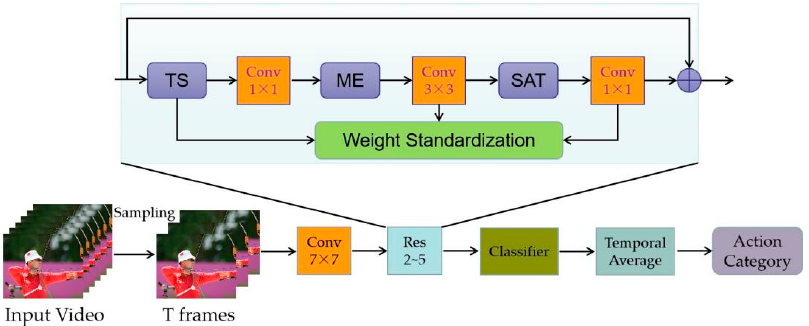
Figure 2. The overall structure of